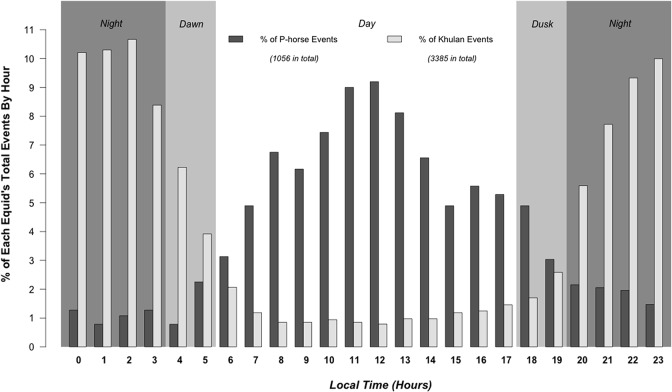
The circadian rhythm (by hour) of P-horse (dark gray) and Khulan (light gray).Each bar represented the percentage of total trapping events of that species recorded in that hour of day. Background colors indicated the day (white), twilight (light gray) and night (dark gray).